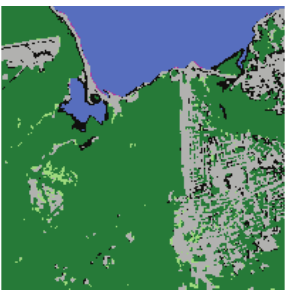
Figure 14: Semantic classification without spatial